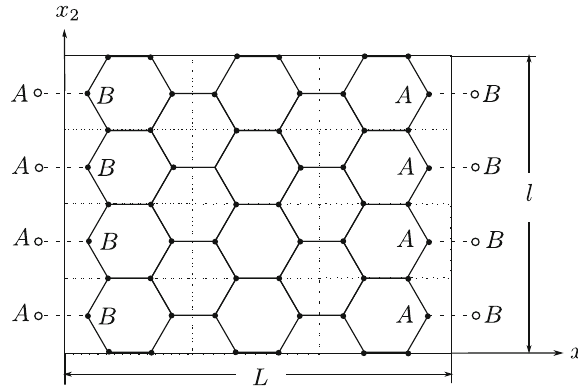
Fig. 5 Unfolded graphene tube ( M = 3 and N = 4). The latticepoints shown by open dots outside the rectangle [ 0 , L ] × [ 0 , l ] are